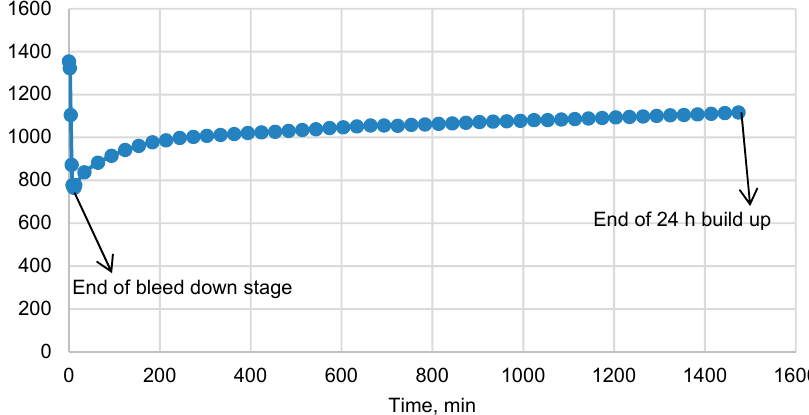
Table 4. System properties as input to the mathematical model (Adapted with permission from Kazemi et. al, SPE, 2014 [14]).